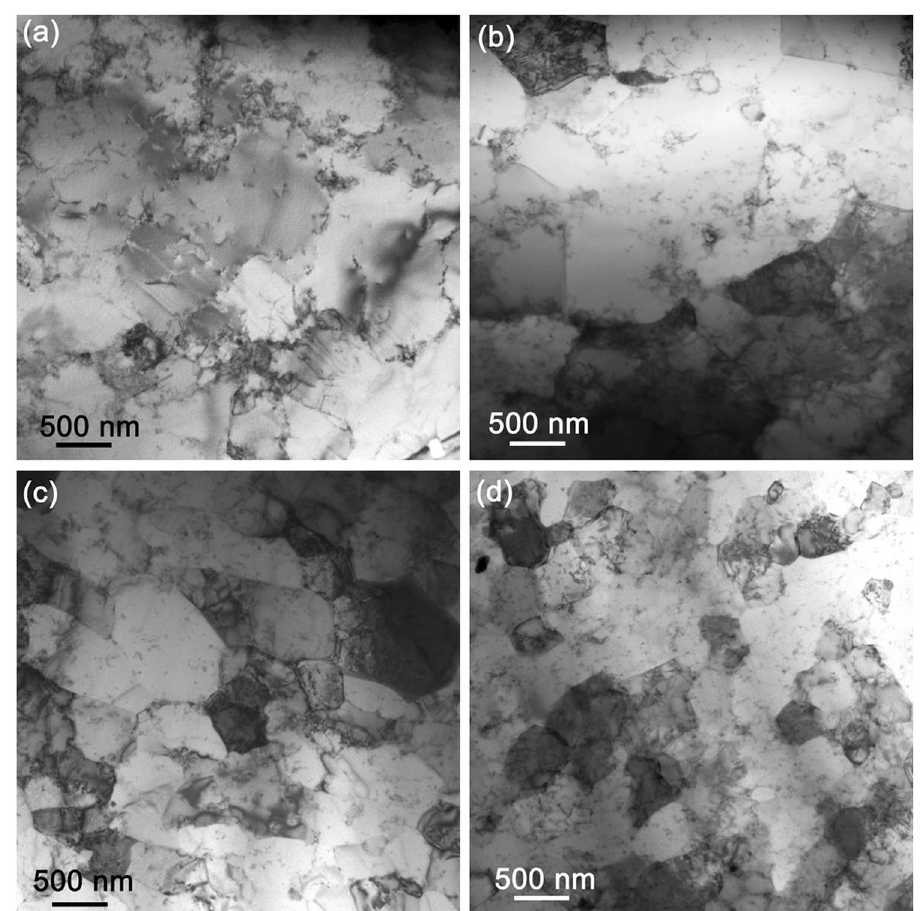
Figure 6. TEM bright field images of transversal-sections of the Al + Al 2 O 3 sheaths of the wA ( a ), wB ( b ), wC ( c ) wires and of the as-deformed one ( d